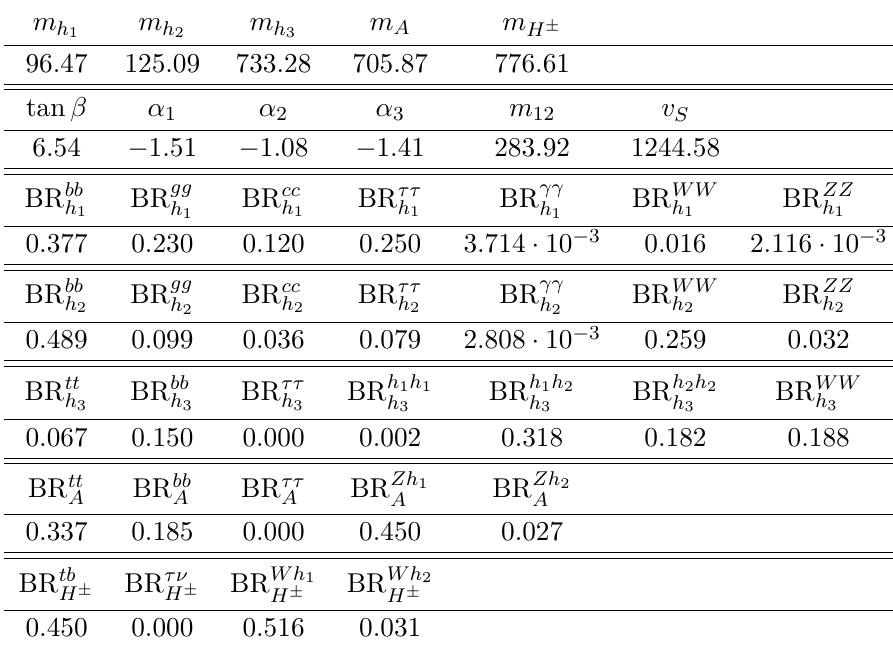
Table 2 . Parameters for the point for which the minimal value of χ 2 condition that ∆ χ 2 < 5 . 99 (orange star, χ 2 = 92 . 66 , χ 2 125 ratios of the scalar particles. Dimensionful parameters are given in GeV, and the angles are given in